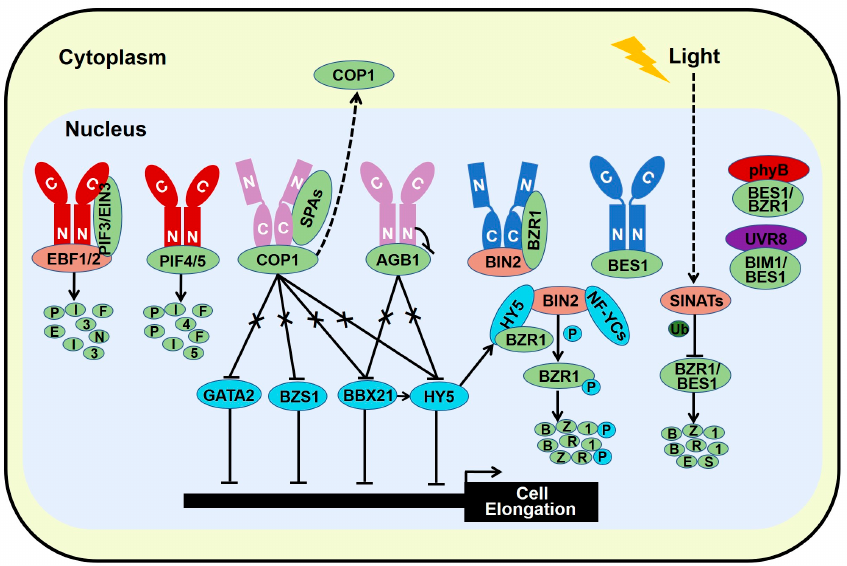
Figure 4. Light and BR share common regulatory components to optimize plant growth and development. Photoexcited phytochromes interact with PIF3/4/5 and EIN3 to promote their